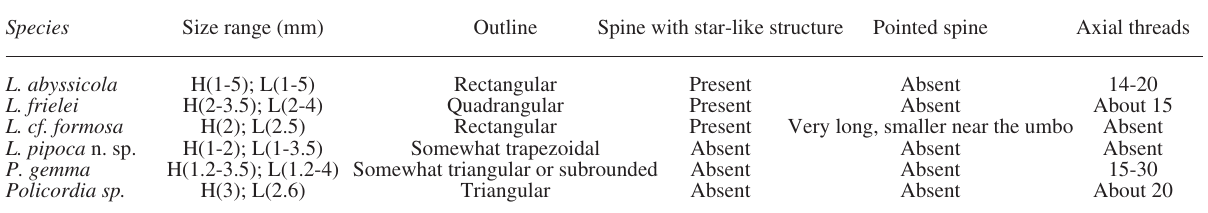
Table 1. – General characters of the species of Lyonsiella and Policordia . H, height; L,